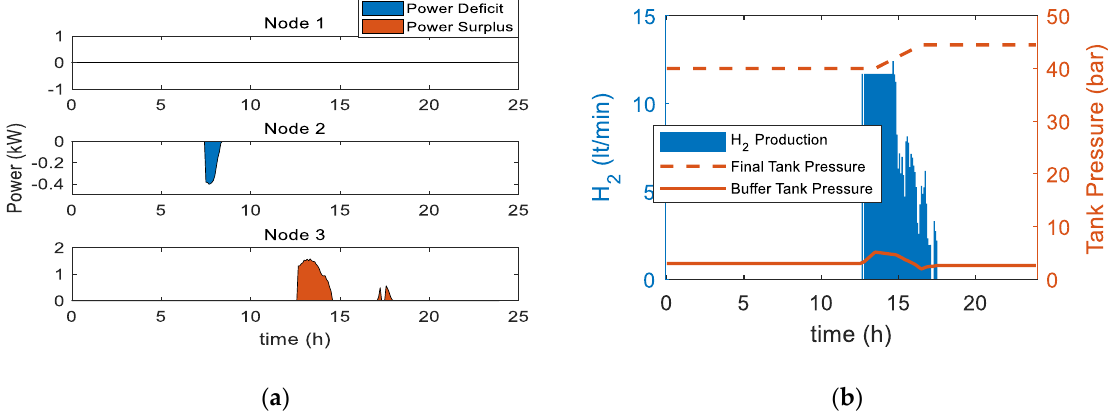
Figure 8. Isolated daily operation (NMPC off) of the microgrid: ( a ) Resulting power shortage/surplus at the nodes; ( b ) Hydrogen production and storage tanks pressures.